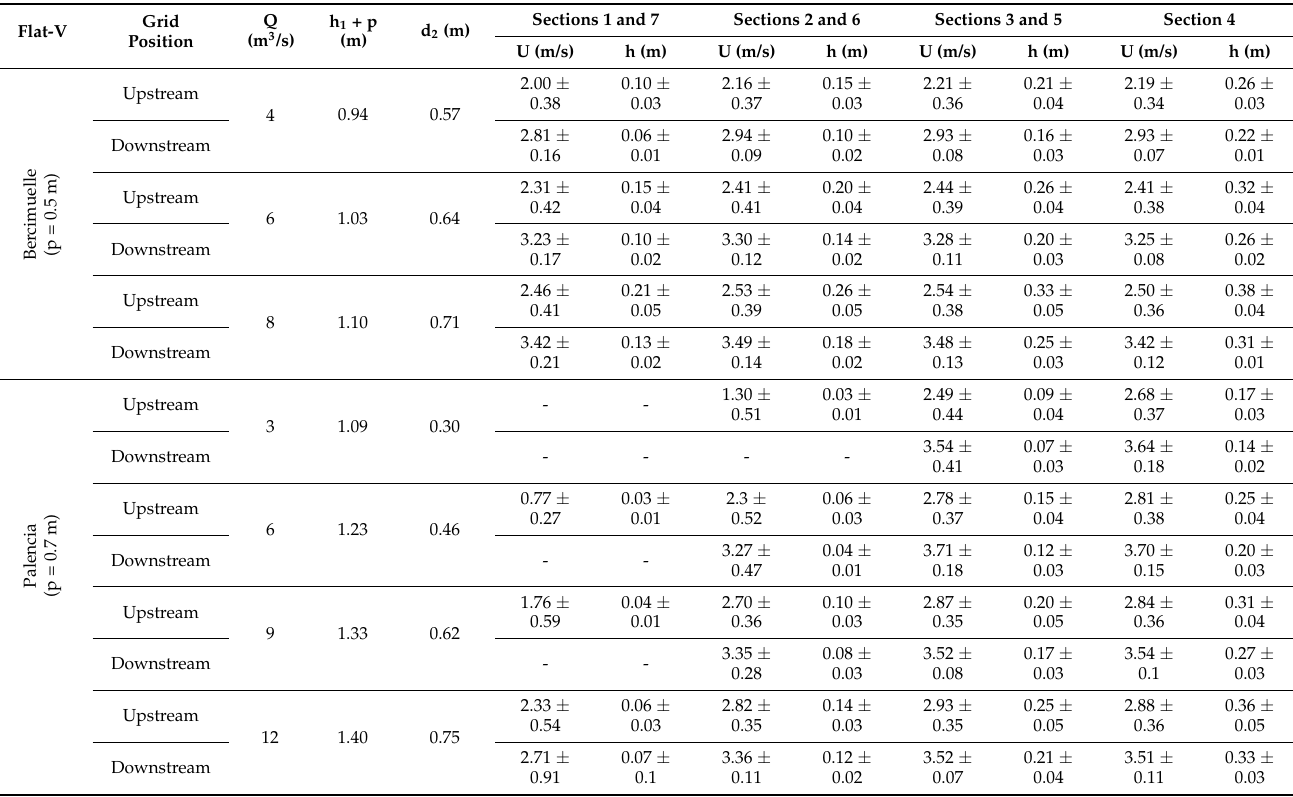
Table 1. Mean velocities and water levels ( ± S.D.) according to simulations in the coarse grid used for analysis. For a simpler layout and considering the symmetry of the flow rate over the weir only half of the mesh results are shown. “-” stands for cells without water for the specific